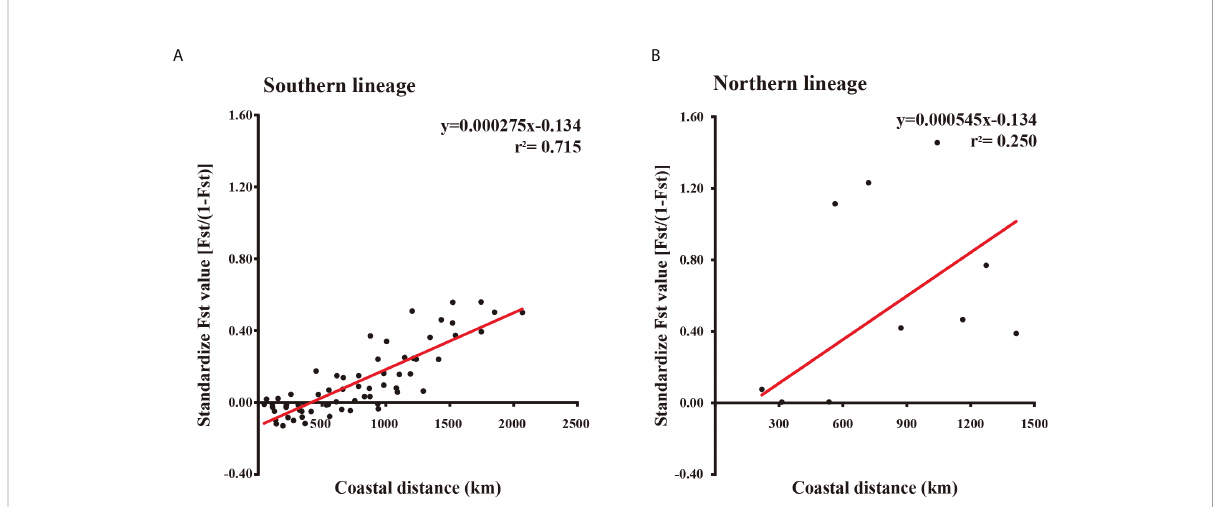
FIGURE 6 Plot of standardized pairwise Fst value vs. geographic distance between sampling sites of the southern (A) and northern (B) lineages. Reduce major axis regression of each plot is indicated with red lines. Regression functions and the coef fi cients of determination (r 2 ) are given on top- right